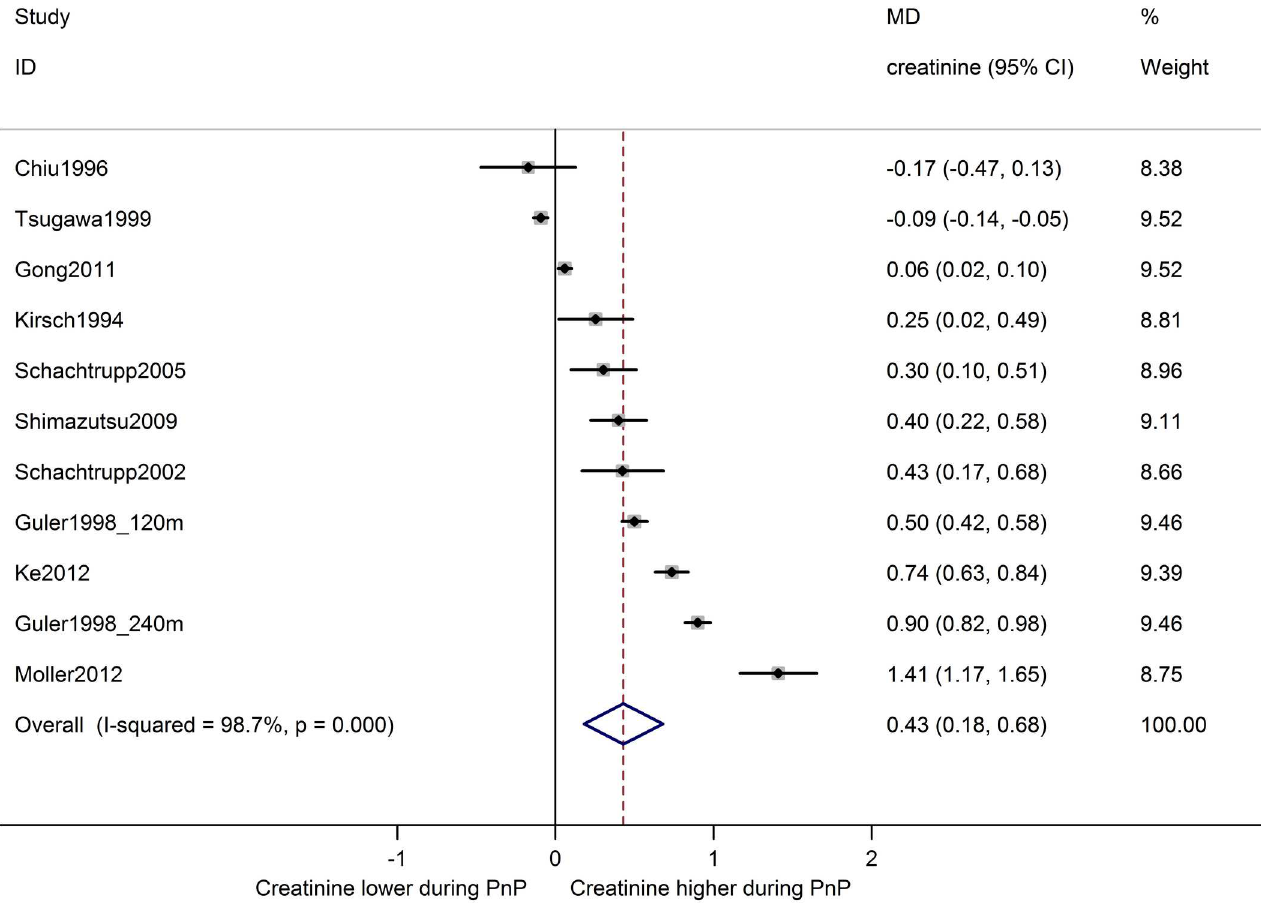
Fig 3. Serum creatinine is increased during pneumoperitoneum compared to baseline. Forest plot of studies comparingserum creatinine during pneumoperitoneum with baselinemeasurements in the same animals. Effect size is calculated as mean difference (MD) in serum creatinine in mg/dl, and corresponding 95% confidence intervals (95%CI). Weights are from random effects analysis. m = duration of PnP in minutes at time of measurement.